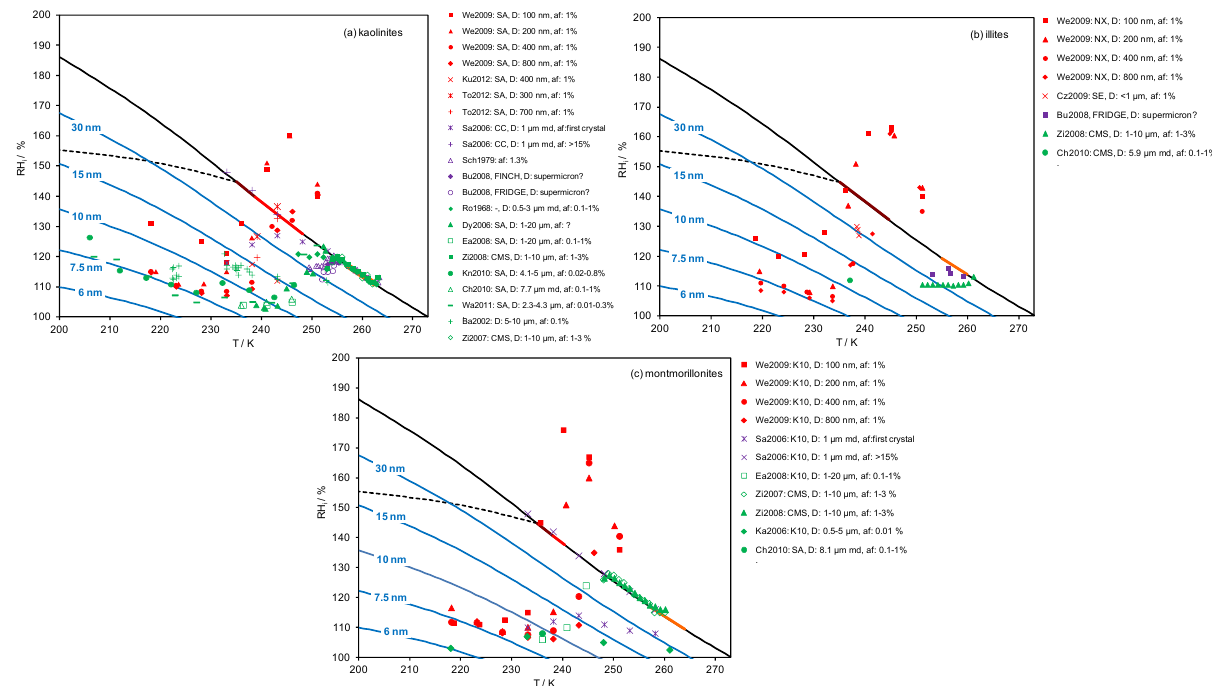
Fig. 5. Ice nucleation data as a function of temperature and relative humidity with respect to ice (RH i ) for (a) kaolinites, (b) illites, and (c) montmorillonites. Red, purple and green symbols encode nucleation on submicron, micron, and supermicron particles, respectively. The solid and dashed black lines indicate liquid water saturation and homogeneous ice nucleation, respectively. The differently colored thick solid lines on the water vapor saturation line give the temperature range for which immersion freezing on standard (brown), special (red) and best sites (orange) has been observed by Pinti et al. (2012) for kaolinite SA (a) , illite NX (b) and montmorillonite K10 (c) . The solid light blue lines give pore filling in dependence on pore diameter. The legend lists the reference of the study, the diameter of the particles ( D ) and the activated fraction (af). Abbreviations: md, mode diameter; SA, Sigma Aldrich; CC, City Chemicals; CMS, Clay Mineral Society. Compositions of kaolinites SA, illites NX and SE (Arginotec), and montmorillonite K10 are given in Pinti et al. (2012). References: We2009, Welti et al. (2009); Ku2012, Kulkarni et al. (2012); To2012, Tobo et al. (2012); Sa2006, Salam et al. (2006); Sch1979, Schaller and Fukuta (1979); Bu2008, Bundke et al. (2008); Ro1968, Roberts and Hallett (1968); Dy2006, Dymarska et al. (2006); Ea2008, Eastwood et al.